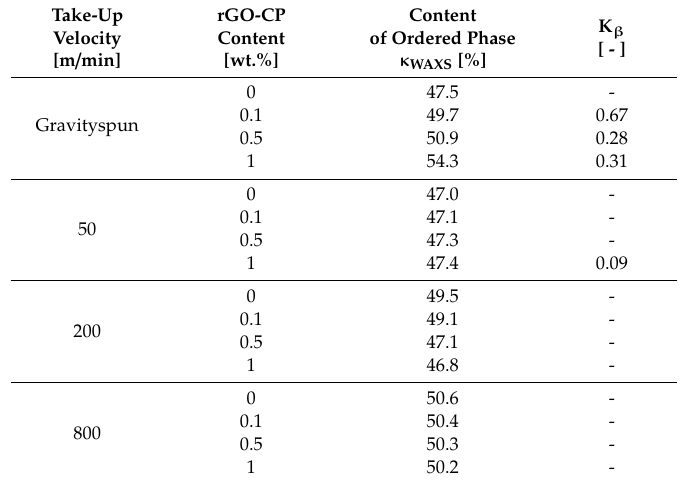
Table 6. Crystalline structure parameters obtained by means of the WAXS method.